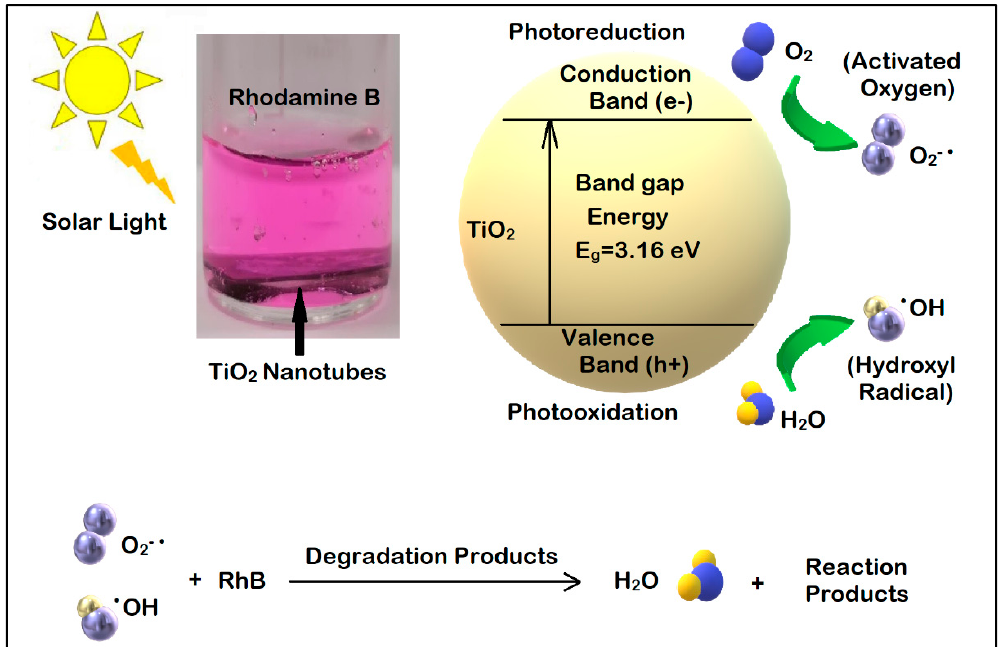
Figure 9. Mechanism of photocatalysis in the presence of the TiO 2 nanotubes and the reactions for the degradation of RhB.